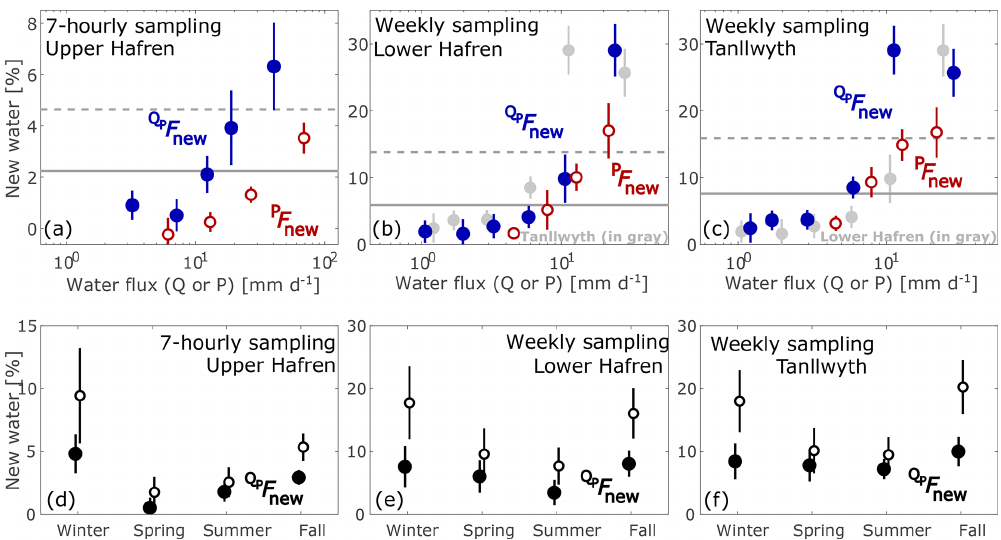
(cid:16) Q (cid:17) (cid:16) (cid:17) P F Figure 10. Event new water fractions and new water fractions of precipitation for different discharge rates, precipitation p F new new rates, and seasons, calculated from time series of oxygen-18. Error bars indicate 1 standard error. In (a) – (c) , solid circles indicate event new water fractions, plotted as functions of discharge rates, and open circles indicate new water fractions of precipitation, plotted as functions of precipitation rates. Gray markers in the background of (b) show event new water fractions from (c) , and vice versa, to facilitate comparison between Lower Hafren and Tanllwyth. Event new water fractions are calculated for different percentiles of the discharge regime (in blue, 0–30, 30–60, 60–80, 80–90, and 90–100 for 7-hourly sampling, and 0–20, 20–40, 40–60, 60–80, 80–90, and 90–100 for weekly sampling; percentiles are calculated based only on discharge of time steps with precipitation, and precipitation thresholds were set to 0mmh − 1 ) . New water fractions of precipitation are calculated for different percentiles of precipitation rates above the precipitation threshold of 0.1mmh − 1 (in red, 0–40, 40–60, 60–85, 85–100). Solid and dashed gray lines indicate unweighted and volume-weighted event new water fractions, respectively, across all discharge values. Panels (d) – (f) show event new water fractions, across all discharge values, determined separately for winter (December–February), spring (March–May), summer (June–August), and fall (September–November). Open and solid circles indicate volume-weighted and unweighted event new water fractions, respectively, in (d) – (f) . thus promoting faster transport of precipitation to the